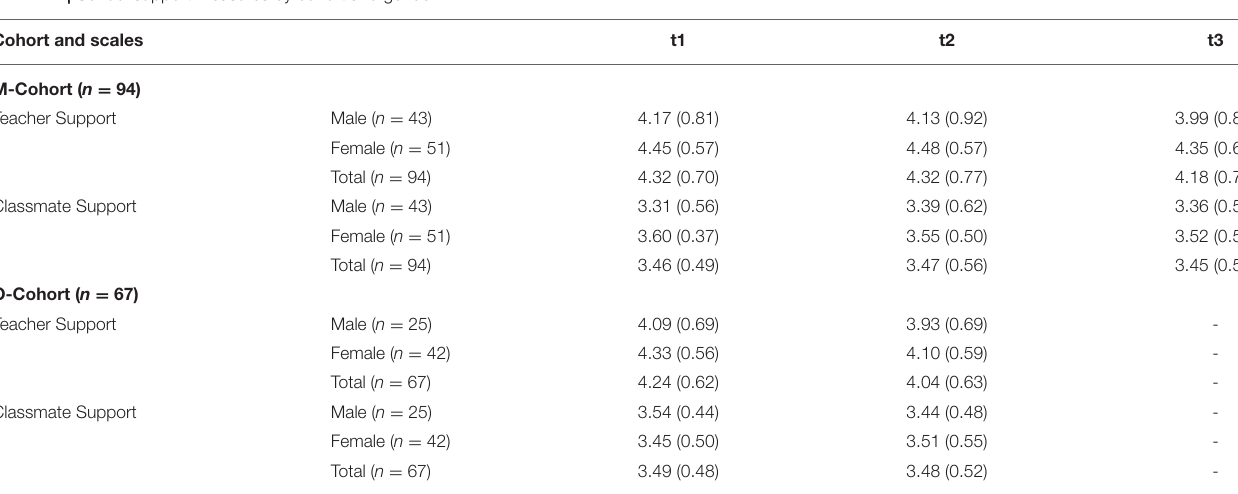
TABLE 2 | School support measures by cohort and